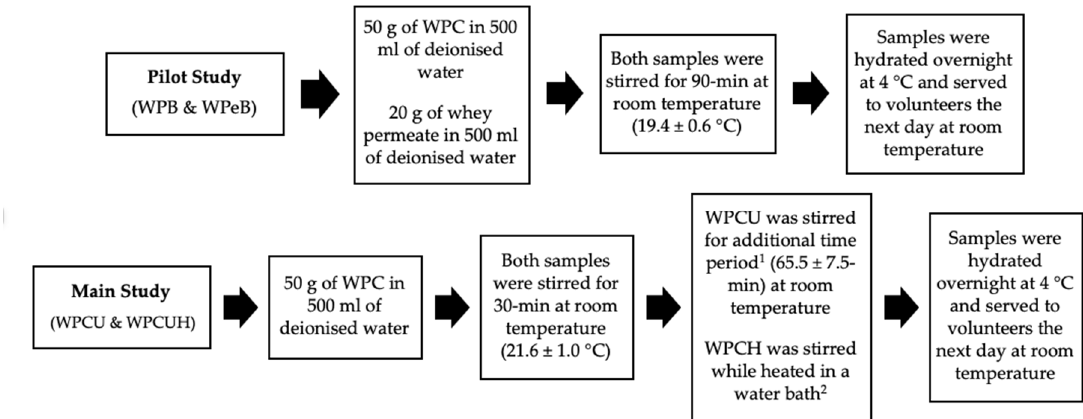
Figure 2. Overview of beverage preparation in both studies (WPB: whey protein beverage; WPeB: whey permeate beverage; WPC: whey protein concentrate; WPCU: unheated WPB; WPCH: heated WPB). 1 additional time period was based on the time it took to heat and cool WPCH; 2 the time to 70 °C was recorded (20.9 ± 4.7-min) and maintained at 70 °C for a further 20-min and cooled to room temperature.